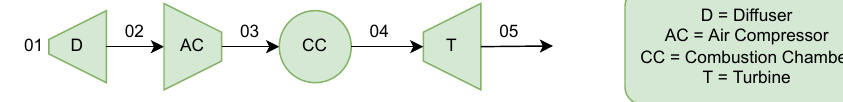
Figure 3. Turboshaft flow diagram.